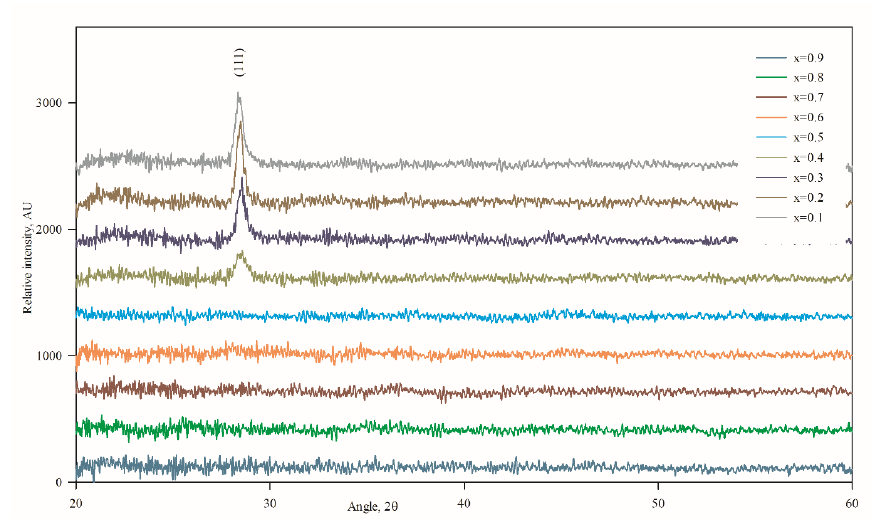
Figure 3. XRD patterns of Zn 1-x Mg x S thin films (0.1 ≤ x ≤ 0.9).